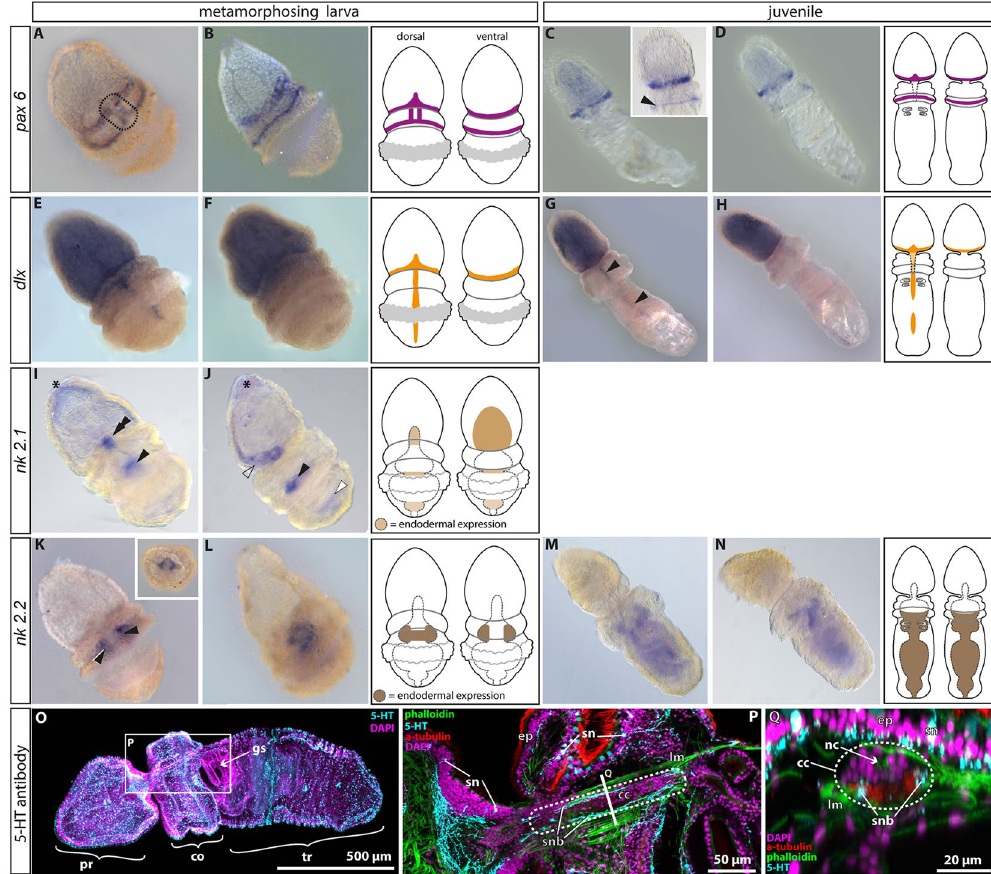
Figure 3. Expression domains of mediolateral patterning genes and serotonin-LIR in B. misakiensis . ( A,B ) BmiPax6 is expressed in the proboscis nerve ring and in a second circumferential domain in the collar ectoderm. Additionally, BmiPax6 forms paired longitudinal domains in the neural plate (dashed area) of the developing larva. In juveniles, the expression in the collar ectoderm fades (inset) and only the proboscis nerve ring shows strong signal of BmiPax6 ( C,D ). ( E – H ) BmiDlx is expressed as a median stripe in the collar and dorsal cord (arrowheads) with an interruption at the level of the telotroch ( E ). The strong staining in the protocoel is unspecific (see also Fig. S1). ( I,J ) Expression of BmiNk2.1 in the metamorphosing larva. BmiNk2.1 is strongly expressed in the stomochord (double arrowhead), in the ventrolateral ectoderm at the base of the proboscis (open arrowhead), in the posterior pharynx (black arrowhead), and weakly in the hindgut (white arrowhead). The degrading apical organ shows a faint signal (asterisk). ( K – N ) Expression of BmiNk2.2 . ( K ) Surface view from ventral showing bilateral domains in the mid-pharynx region. ( L ) Lateral view from left. Inset shows a cross section of the collar region with the ventrolateral domain of BmiNk2.2 in the pharyngeal endoderm. In juveniles the expression domain of Nk2.2 is extended throughout the entire endoderm ( M,N ). Note that there is no ectodermal or neuronal expression domain of BmiNk2.2 . ( O – Q ) Serotonin-LIR in the juvenile. ( O ) Overview. ( P ) Detail of the collar region as indicated in G. Partial Z-projection focussing on the collar cord (dashed area). ( Q ) Virtual cross section of the collar cord as indicated in H. Note that 5-HT + somata are absent from the collar cord (dashed area). Only two ventrolateral 5-HT + neurite bundles pass the ventral area of neurites. cc = collar cord, co = collar, ep = epidermis, g s = sill slit, lm = longitudinal muscles, nc = neural canal, pr = proboscis, sn = serotonin-LIR neuron, snb = serotonin-LIR neurite bundle, tr = trunk. ( A,C,E,G,I,K,M ): dorsal views, ( B,J,L,N ): lateral views left, ( D,F,H ): ventral